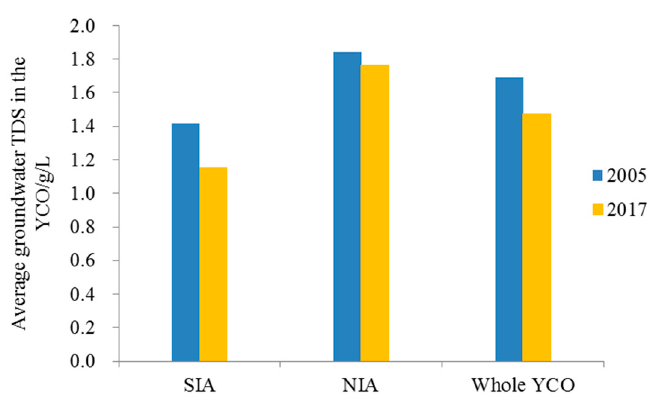
Figure 9. Average groundwater TDS in the YCO after the Agricultural Water-saving Transformation Project (AWSTP). Table 3. Classification area and proportion of groundwater TDS in the Yinchuan Plain.